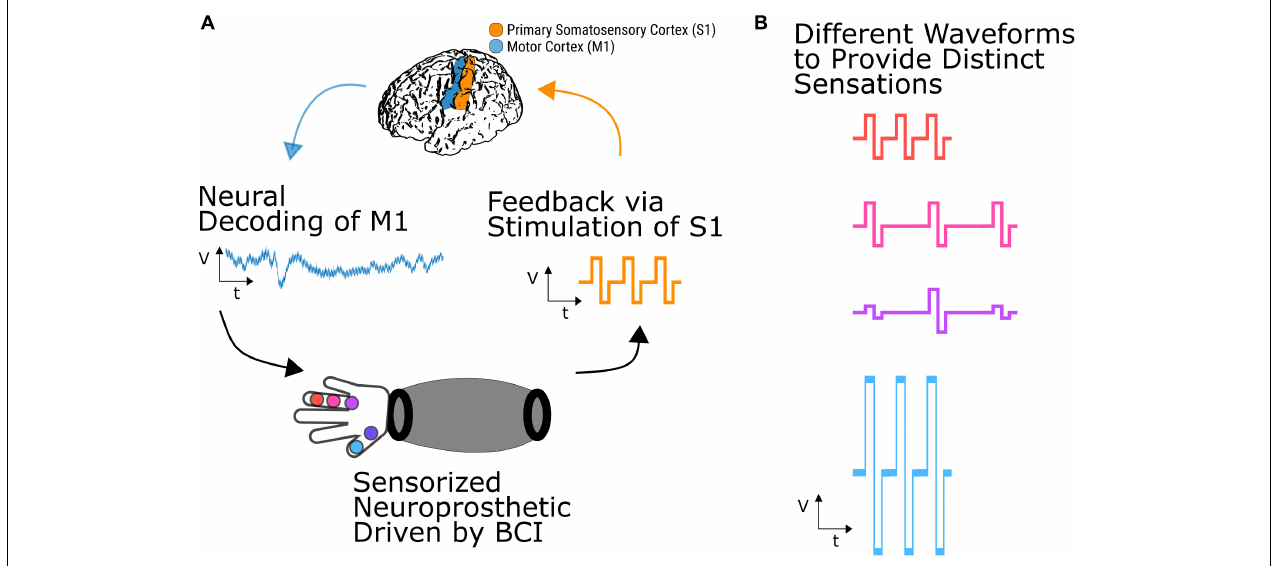
FIGURE 2 | Somatosensory BCI with closed-loop stimulation. (A) Neural signals recorded from cortical regions such as primary motor cortex could be used to drive a sensorized prosthetic arm. Feedback about task performance or object manipulation could then be conveyed to the user by DES of primary somatosensory cortex. (B) Different stimulation parameters, such as amplitude, frequency, and carrier frequency shape, could convey different percepts which a user could learn to map to locations on the neuroprosthetic